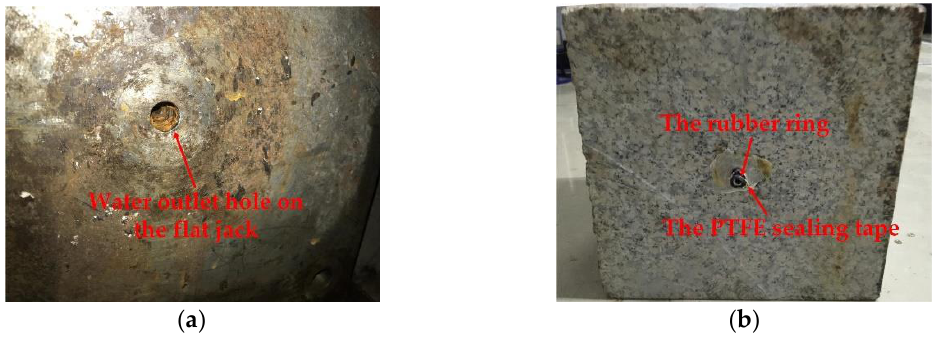
Figure 5. ( a ) The water outlet hole in the flat jack; ( b ) the water inlet on the rock, the black color ring is the rubber ring, and the white color wrapped the black color is the PTFE sealing